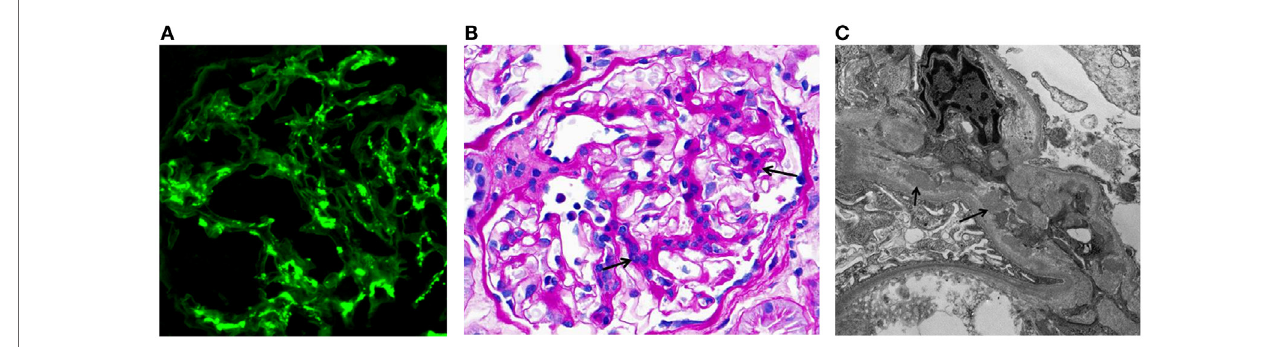
FiGURe 1 | examples of immunofluorescence-, light-, and electron-microscopy features of renal biopsy specimens from patients with igAN . (A) Immunofluorescence staining for IgA in a kidney biopsy specimen from a patient with IgAN showing mesangial staining. (B) Periodic acid–Schiff staining of a kidney biopsy specimen from a patient with IgAN. Arrows indicate mesangial expansion and hypercellularity. (C) Electron micrograph of kidney biopsy specimen from a patient with IgAN. Arrows point to examples of electron-dense material representative of mesangial and paramesangial immune complex deposits. Images are courtesy of Dr. Huma Fatima (B,C) and Dr. Lea Novak (A) , Department of Pathology, UAB.